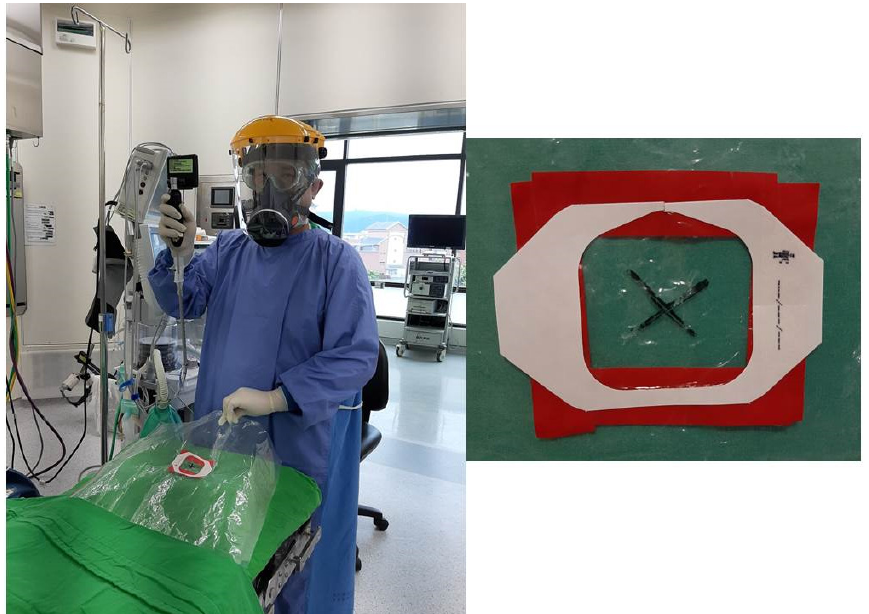
Figure 12. Only a small crosscut in the plastic sheet is needed (marked by X) to allow advancement of the video-assisted intubating stylet.